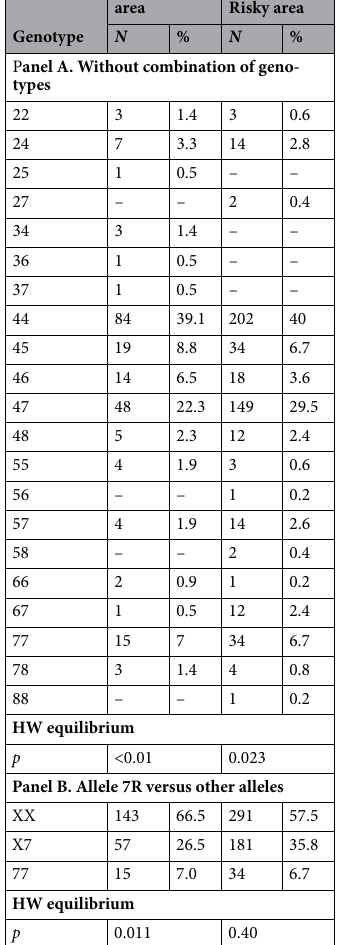
(Table S.3). Our data is consistent with field data and laboratory experiments showing that people exposed to high background risk tend to exhibit less risk-tolerance, in accordance with the “risk-vulnerability hypothesis” 32,33 . Genotypes by zone. Genotypes at the DRD4 locus displayed two common alleles (4R and 7R, with 4 and 7 repeats, respectively), which was expected for populations in Sub-Saharan Africa 9 , and 5 minor alleles with negligible frequencies (2R, 3R, 5R, 6R and 8R) leading to 21 different genotypes (Table 1). The 7R allele was more prevalent than previously found in other African populations 9 , possibly because the ethnic groups from participants were not sampled in previous work. In Chang et al., 1996, the groups analyzed are Bantu and San Bushmen, from South-Africa and Namibia, Biaka from the Central African Republic, Mbuti from the Demo- cratic Republic of Congo and Falasha in Ethiopia. The closest group from our sample geographically would be the Biaka people from the Central African Republic, 5,000 km away. Within each area, populations were not at Hardy-Weinberg equilibrium ( p < 0.01 in the non-risky area, p = 0.02 in the risky area), and displayed an heterozygote deficiency ( F IS = 0.134 in the non-risky area, and F IS = 0.052 in the risky area). Because we were primarily interested in the effect of the 7R allele on risk-taking, we combined all other alleles into a single category, identified as allele “X”. This combination yielded three genotypes: XR/XR, XR/7R and 7R/7R. Hardy-Weinberg equilibrium was rejected ( p = 0.01 ) for the non-risky area, but not for the risky area ( p = 0.40 ), see Table 1. Deviations from HW equilibrium were F IS = 0.181 in the non-risky area, and F IS = 0.037 in the risky area. We found evidence of limited migration. In the risky area, 81% of our sample were born in the same village, as were 72% of their parents, and 68% of grand parents. Numbers were slightly lower for the non-risky area, with 67% of participants, 58% of their parents and 50% of their grand parents (Table S.6).